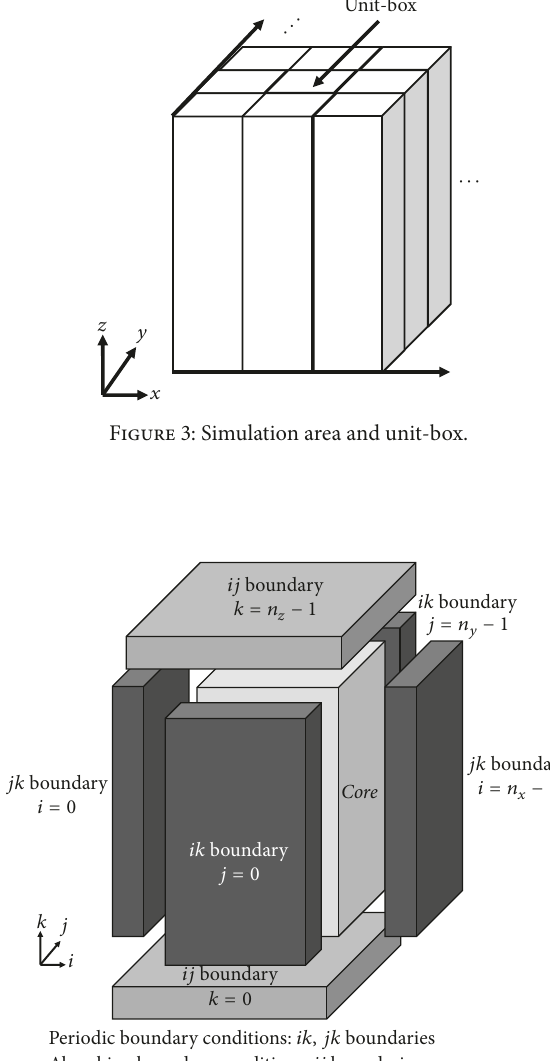
Figure 4: 3D computation domain of a